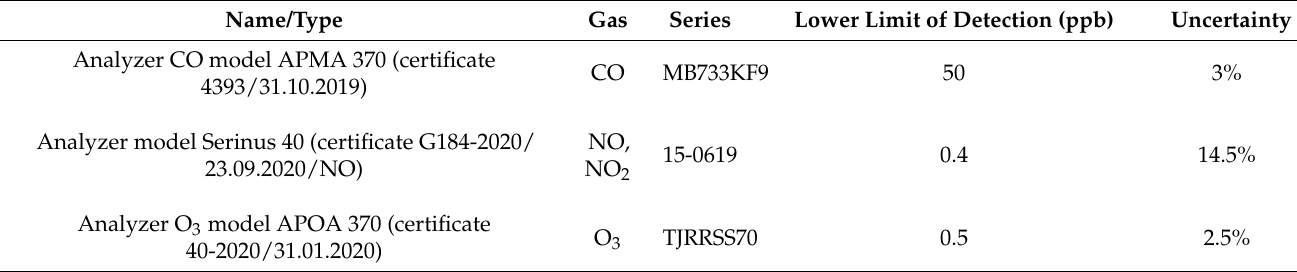
Table 3. Reference station sensor certificates.